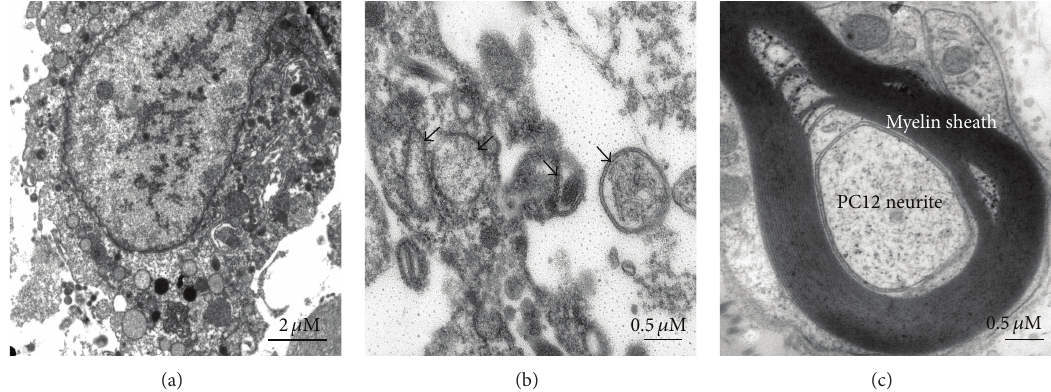
Figure 9: TEM observation showed that SC-like cells formed myelin sheath covering the neurites of PC12 cells (c). Myelin structures were not found when SC-like cells were cultured alone without PC12 cells (a). REMSCs could not form myelin structures with PC12 cells, and the arrows indicated that there was no myelin structure around the neurite. Bar: 2 𝜇 m (a), 0.5 𝜇 m ((b) and